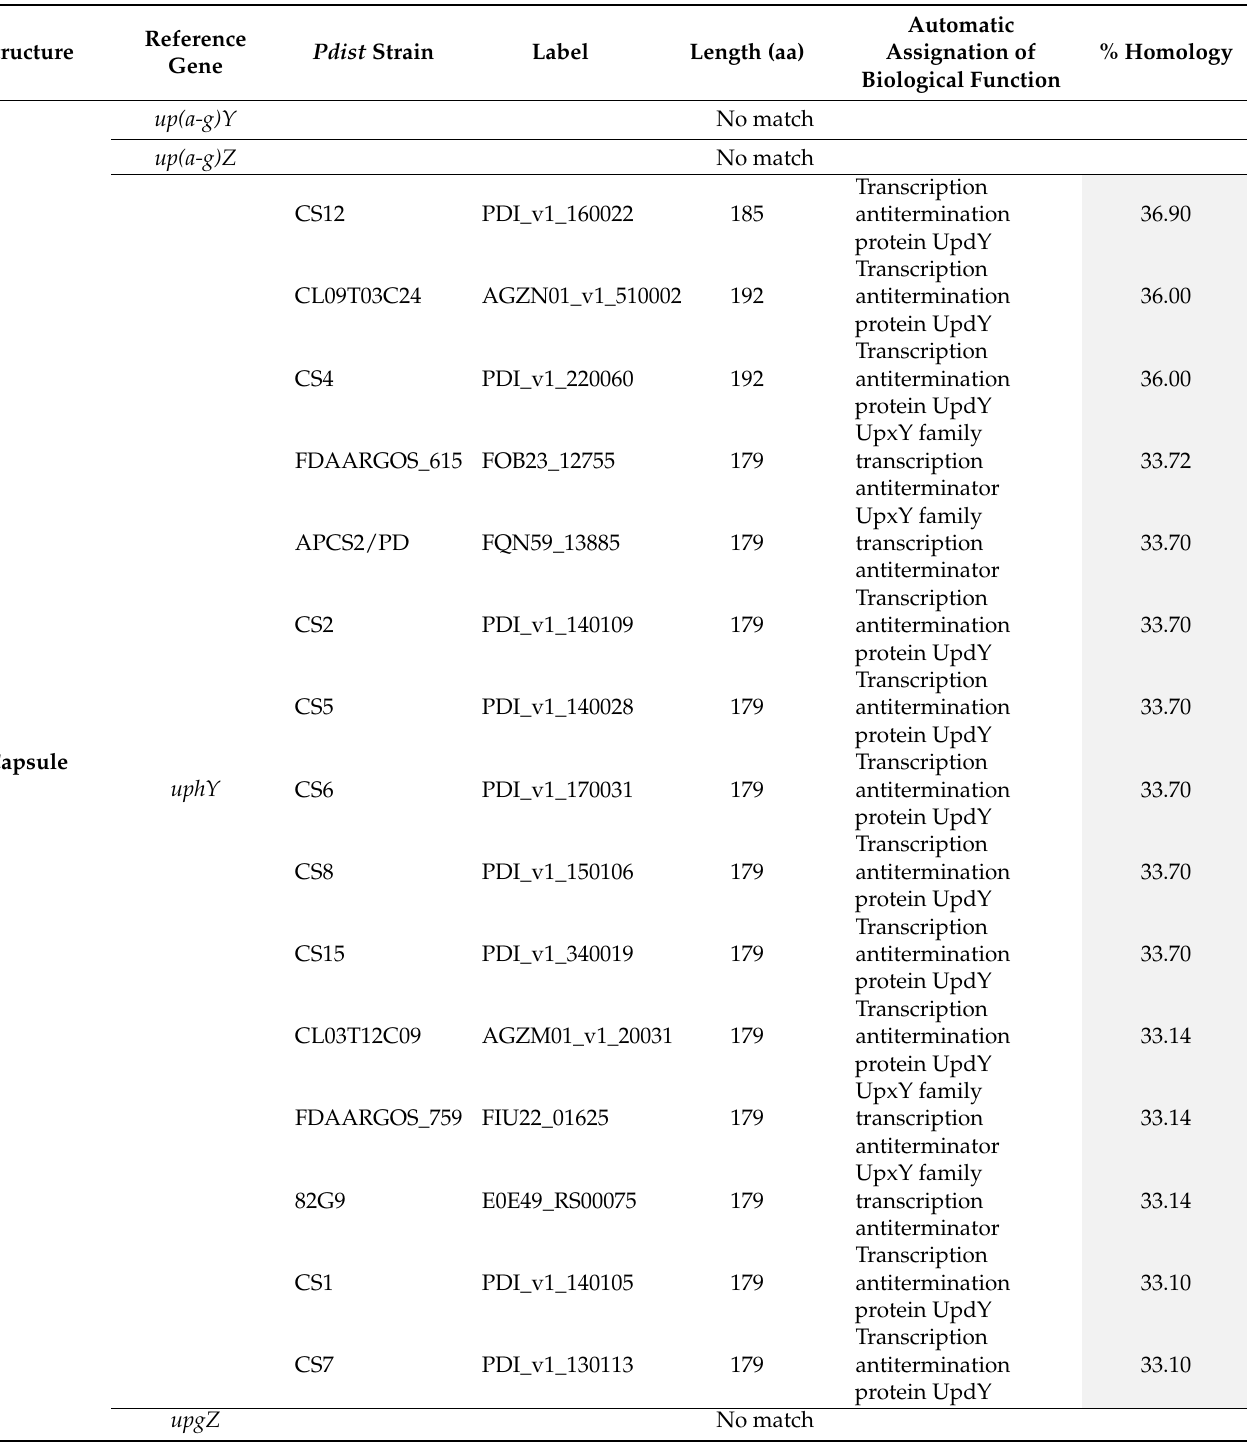
Table 2. P. distasonis genes sharing synteny with reference genes and auto-assigned as part of CPS, fimbriae or pili